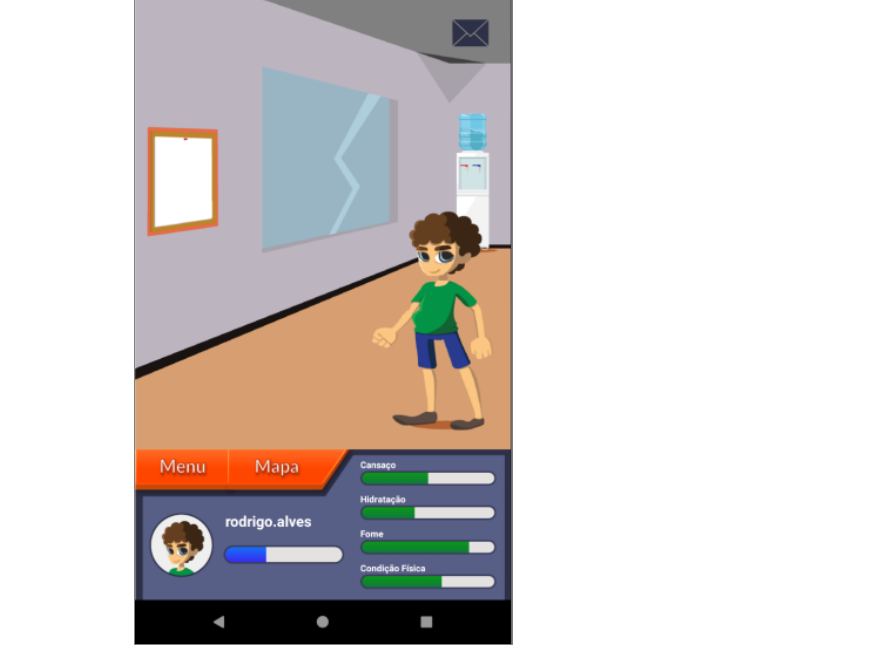
Figure 7. “Ginásio” Gym section —presents the fatigue (“cansaço”); hydration (“hidratação”); hunger (“fome”) and physical condition (“condição física”)— affordance; consistency.